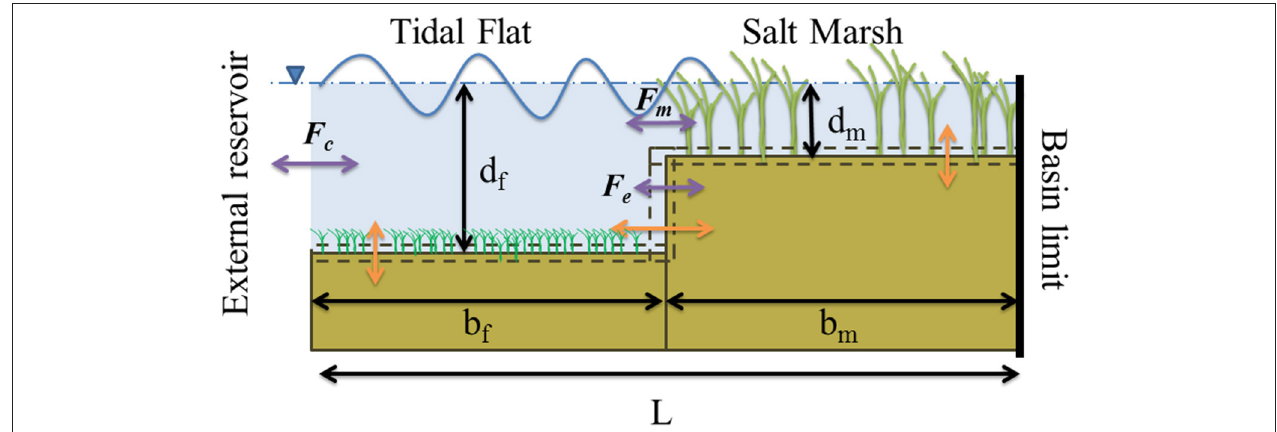
FIGURE 1 | Schematic of the basin. Three independent variables are used to describe the basin geometry: salt marsh depth, d m , tidal flat depth, d f , and tidal flat width, b f . Assuming a fixed width of the basin, L , the marsh width, b m , is a dependent variable. Changes in configuration (orange) arise from exchange of sediment (purple) from the external reservoir and the tidal flat, F c , fluxes arising from boundary erosion or accretion, F e , and the sediment flux to vertical marsh surface from the tidal flat, F m